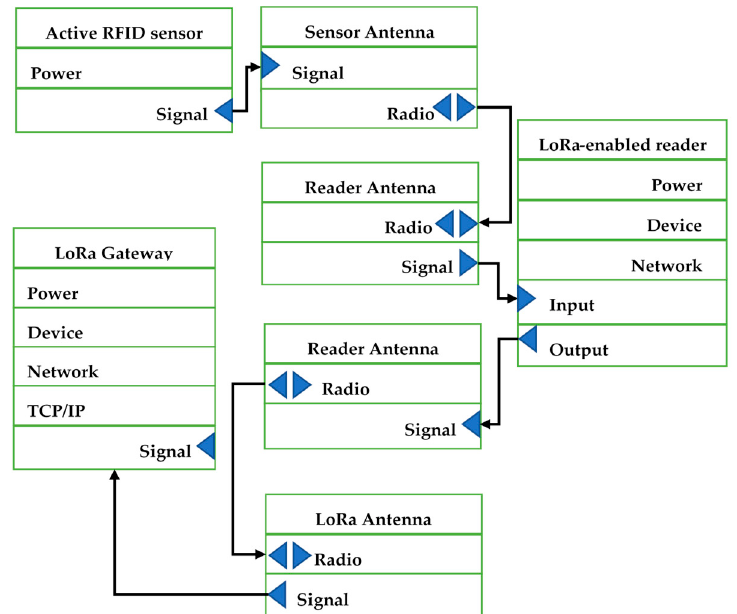
Figure 5. RFID location module connectivity.